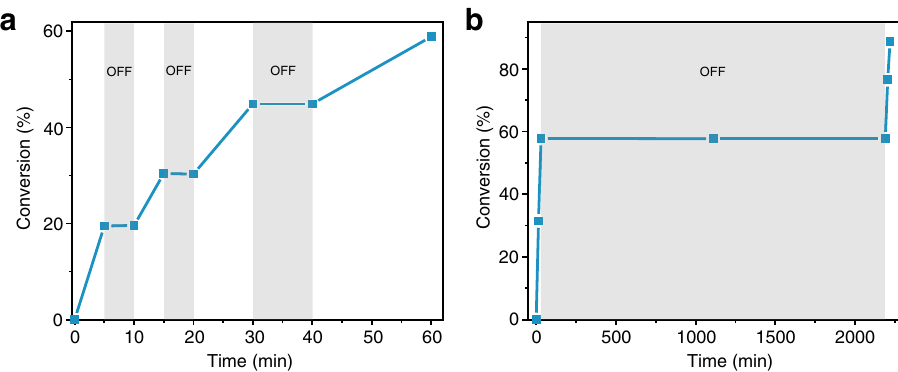
Fig. 5 Temporal control of polymer chain growth via on-off light switching. a Monomer conversion of p -MOS by using OPC 1 and CTA 2a with short dark intervals. b Prolonged dark period (36 h) to demonstrate excellent